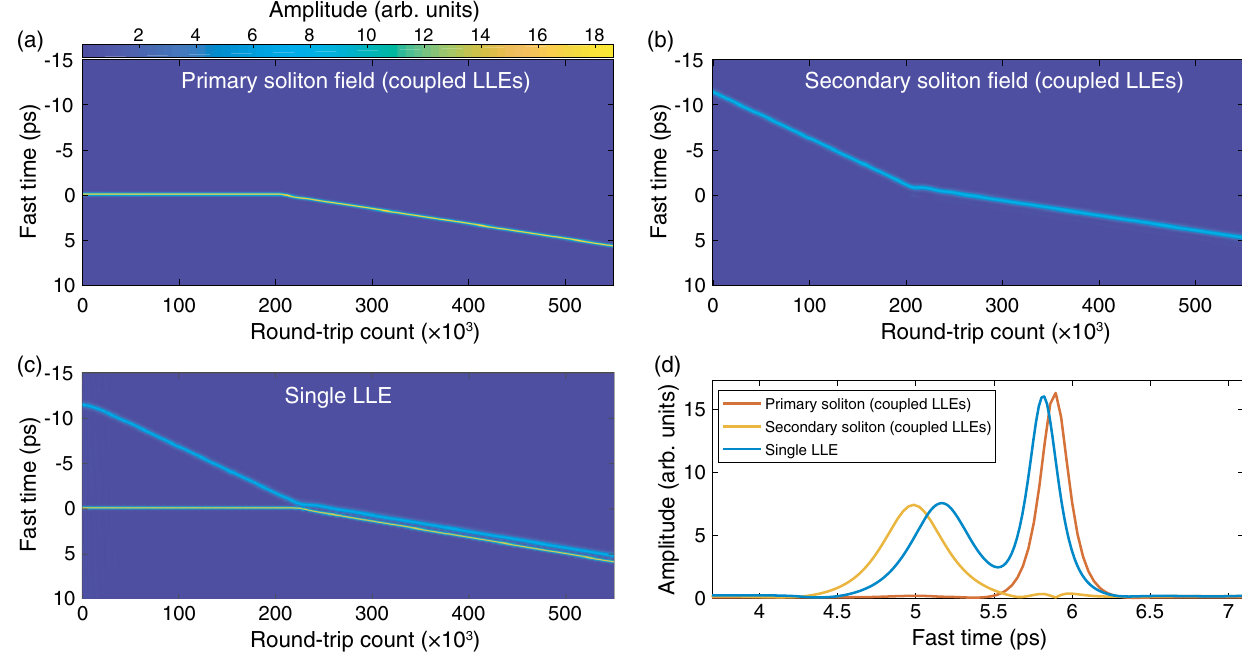
FIG. 7. Comparison between the single-LLE model and the model of the coupled LLEs. (a),(b) The respective evolutions of the primary field and the secondary field calculated by the coupled LLEs show the binding of a primary soliton and a secondary soliton. (c) The same binding process simulated with the single-LLE model. (d) The final frames in each simulated field